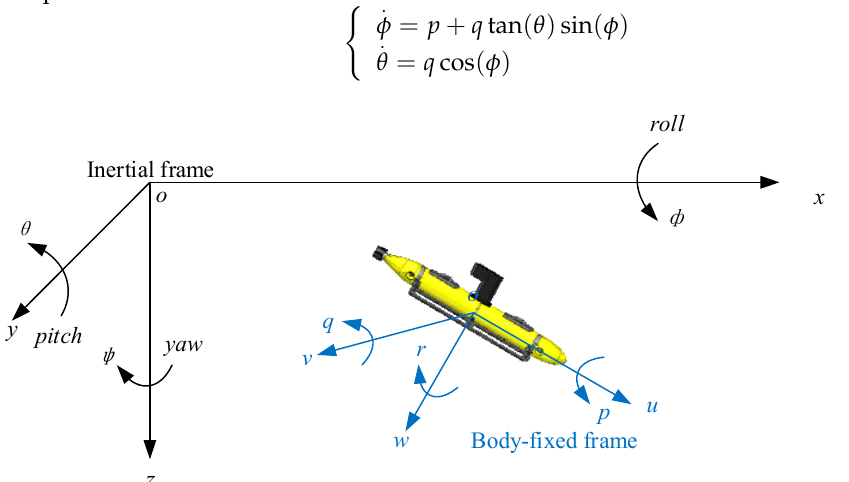
Figure 4. The inertial and body ‐ fixed frames of AUV.